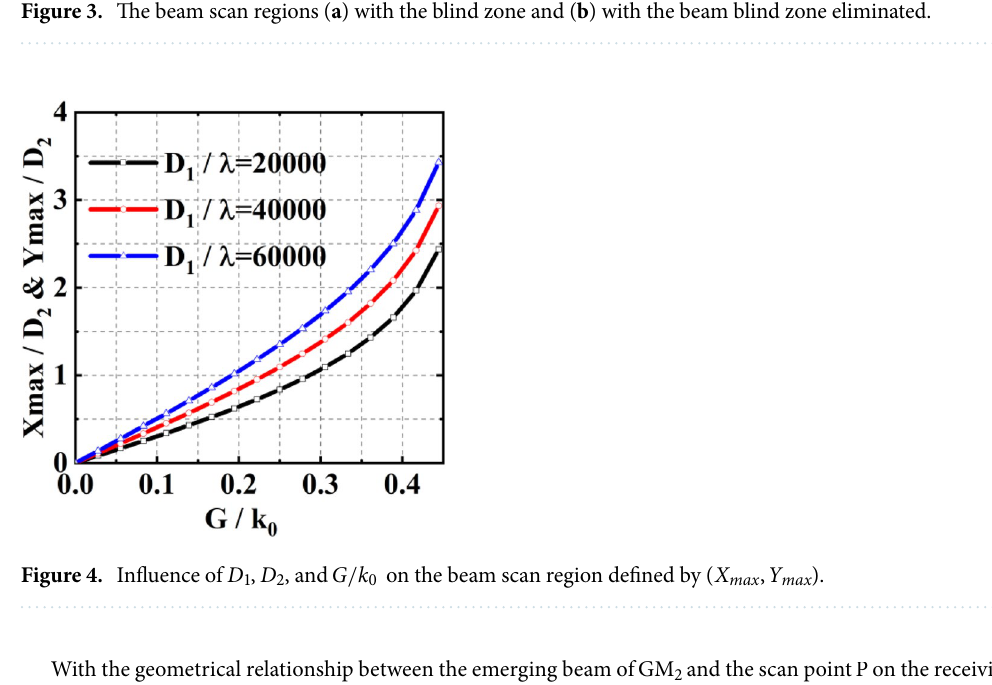
Figure 3. The beam scan regions ( a ) with the blind zone and ( b ) with the beam blind zone eliminated.